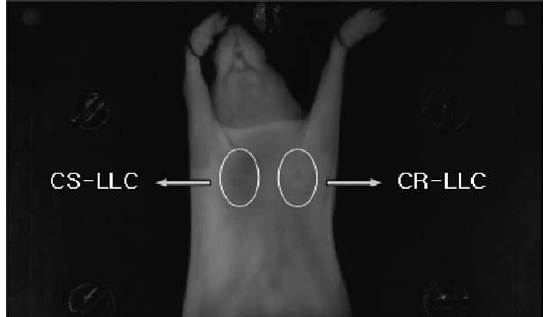
Fig. 1. The position of tumor implantation in the